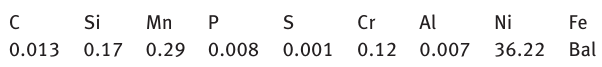
Table 1: Chemical composition of the Fe-36% Ni invar alloy (mass%) C Si